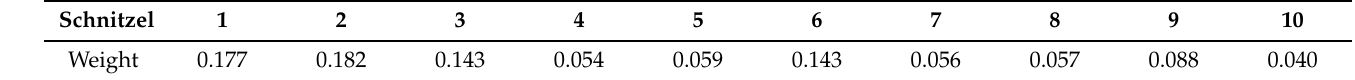
Table A12. Weight of each criterion for